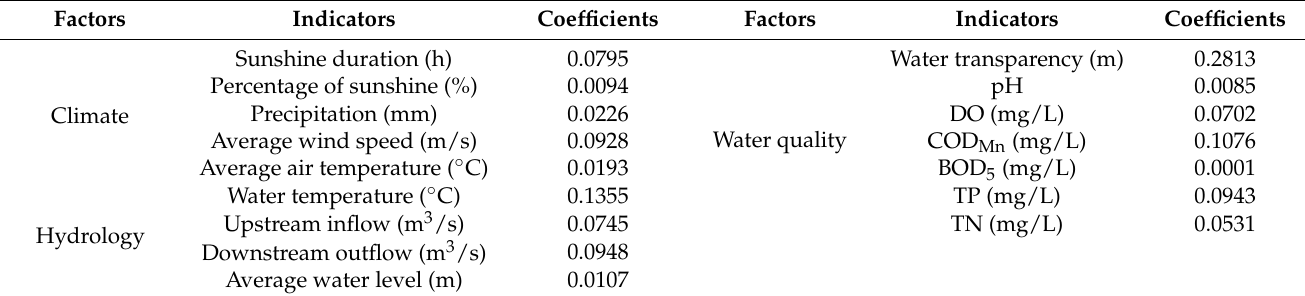
Table 2. Pearson correlation coefficients between Chl-a concentrations and impact